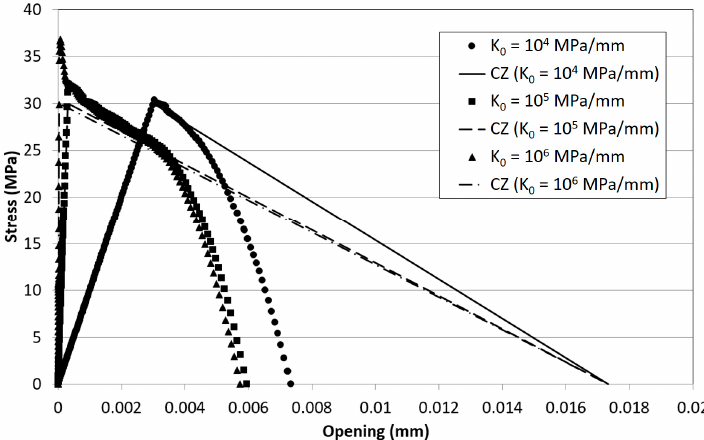
Figure 9. Stress as a function of opening in cohesive elements for G/G c = 0.5.